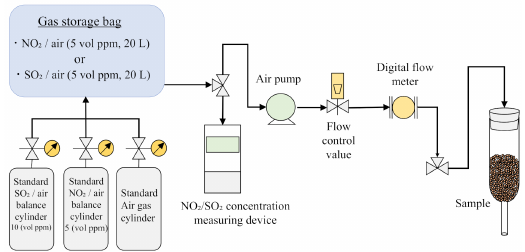
Figure 5. A schematic diagram of the NO 2 or SO 2 adsorption